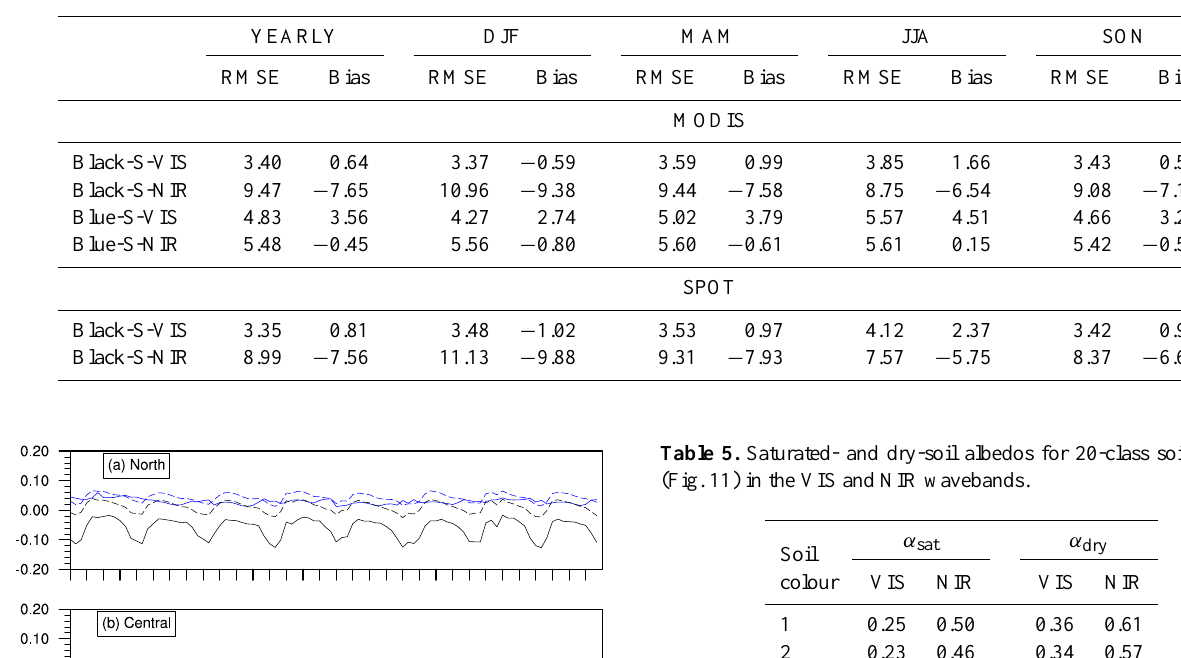
Table 4. Same as in Table 3 but for the PSALB experiment.